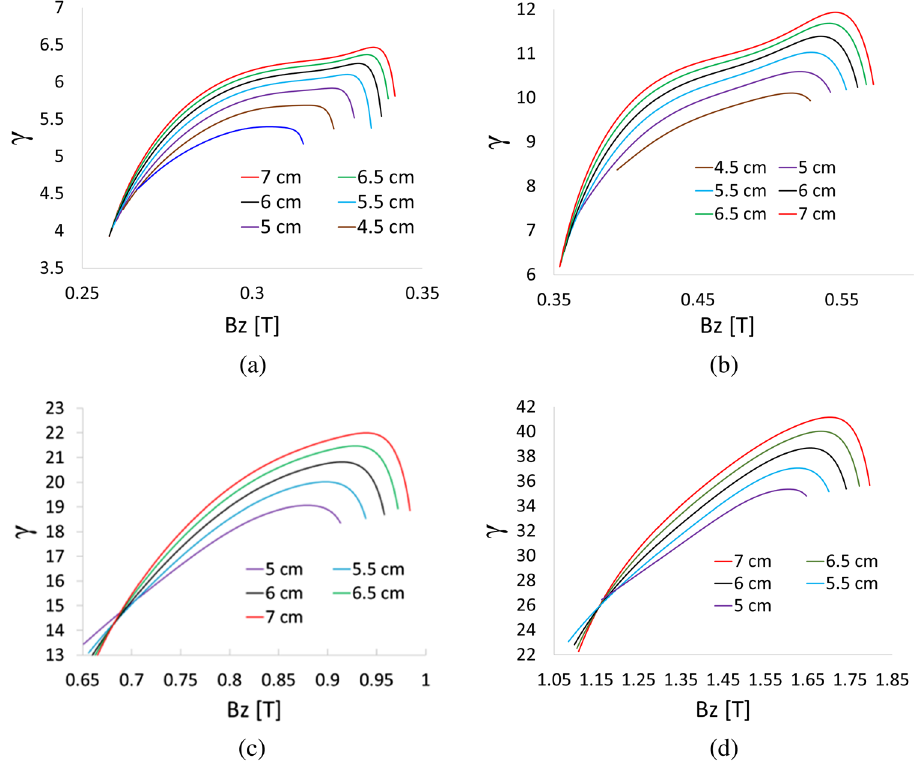
FIG. 4. Behavior of final values of γ vs B as electrons exit cavities of various radii, with curves labeled according to the cavity radius o ¼ 20 MV=m (b) E ¼ 50 MV=m (c) E ¼ 100 MV=m (d) E ¼ 200 MV=m . Eneries of accelerated electrons in these R in cm. (a) E w w w w examples are between about 2 and 20